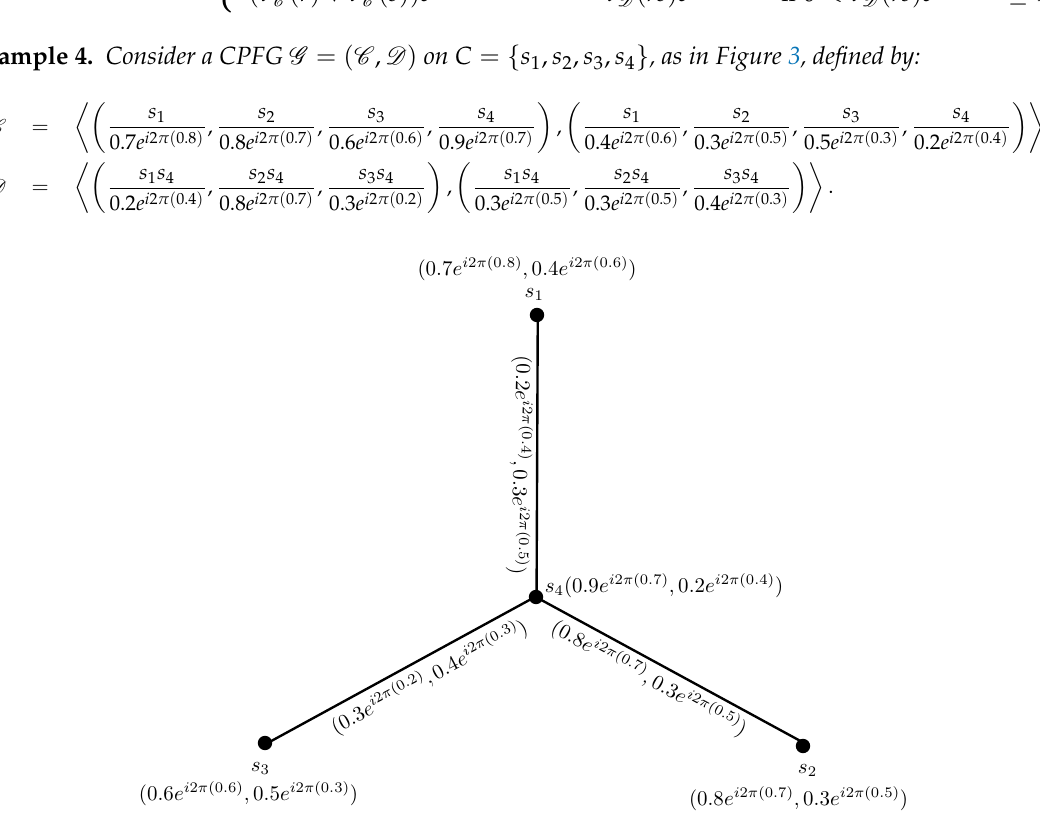
Figure 3. Complex Pythagorean fuzzy Figure 3: Complex Pythagorean fuzzy graph.